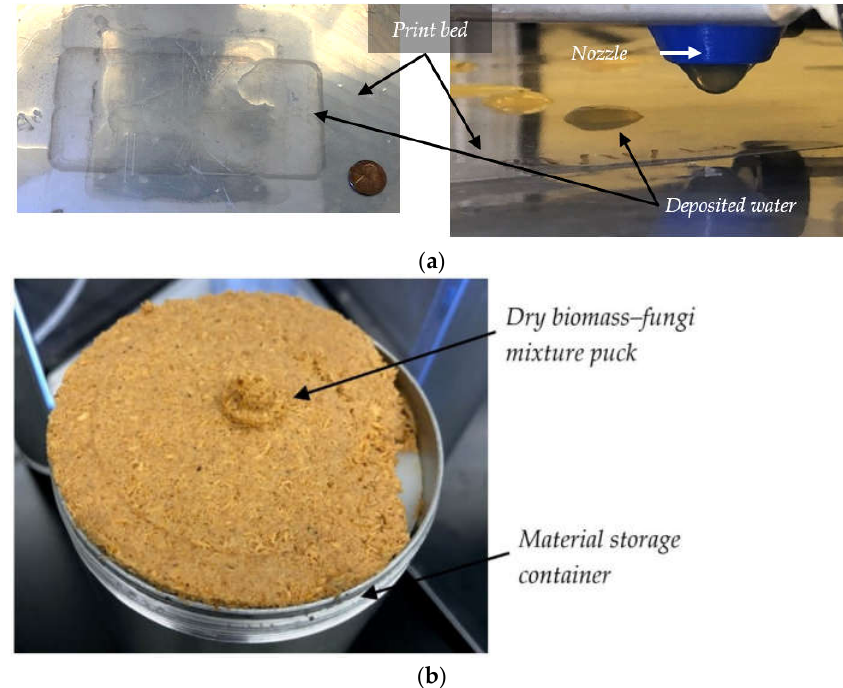
Figure 7. Printing results for mixture A: ( a ) only water from the biomass–fungi mixture was deposited during the printing process; ( b ) non-extrudable, dry biomass–fungi mixture puck left behind.